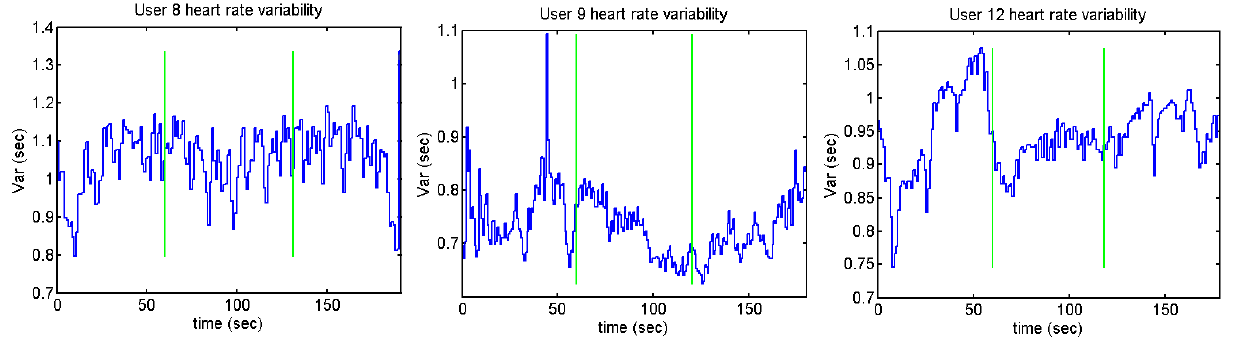
Figure 38. Heart rate variability of User 12 from Stroop